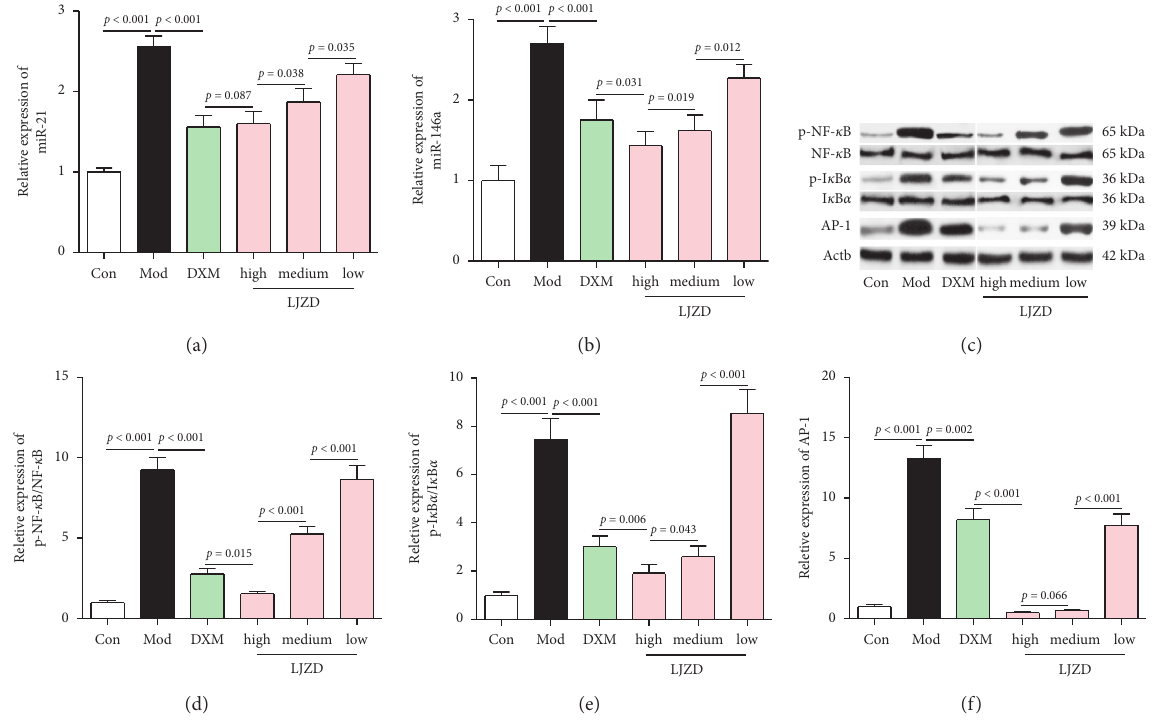
Figure 6: LJZD reduced miR-21 and miR-146a expression and suppressed the activation of the NF- κ B signaling pathway. Real-time PCR analysis of the miR-21 (a) and miR-146a (b) expression in lung tissues of the Con, Mod, DXM, and high-, medium-, and low-dosage LJZD groups. (c) The representative images of western blotting analysis of NF- κ B, phospho (p)-NF- κ B, I κ B α , p-I κ B α , and AP-1 expression in lung tissues of all the groups. The relative expression levels of p-NF- κ B (d), p-I κ B α (e), and AP-1 (f) are shown, and Actb was used as an internal control. Data were expressed as the mean ± SD ( n � 3). NF- κ B: nuclear factor kappa-B, I κ B α : NF- κ B inhibitor alpha, and AP-1: activating protein-1.